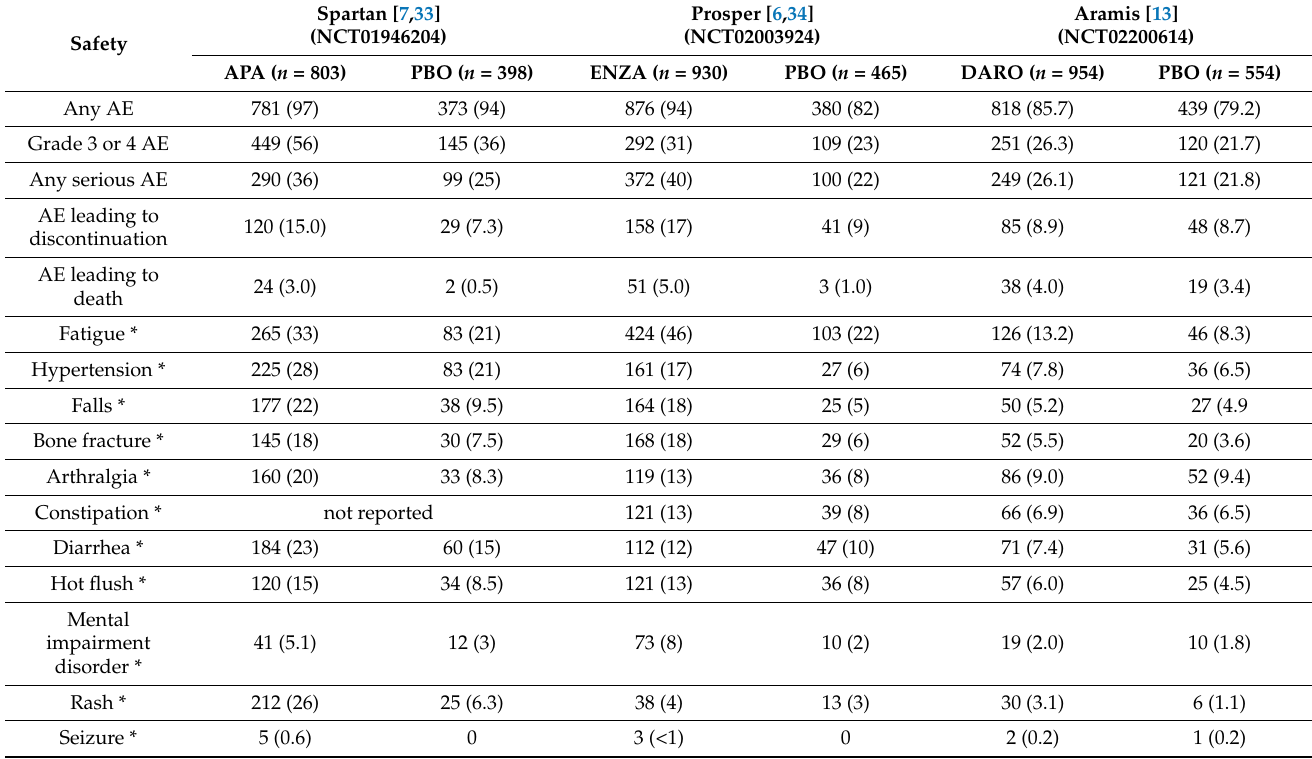
Table 3. Comparison of safety profile in nmCRPC treatment phase 3 clinical